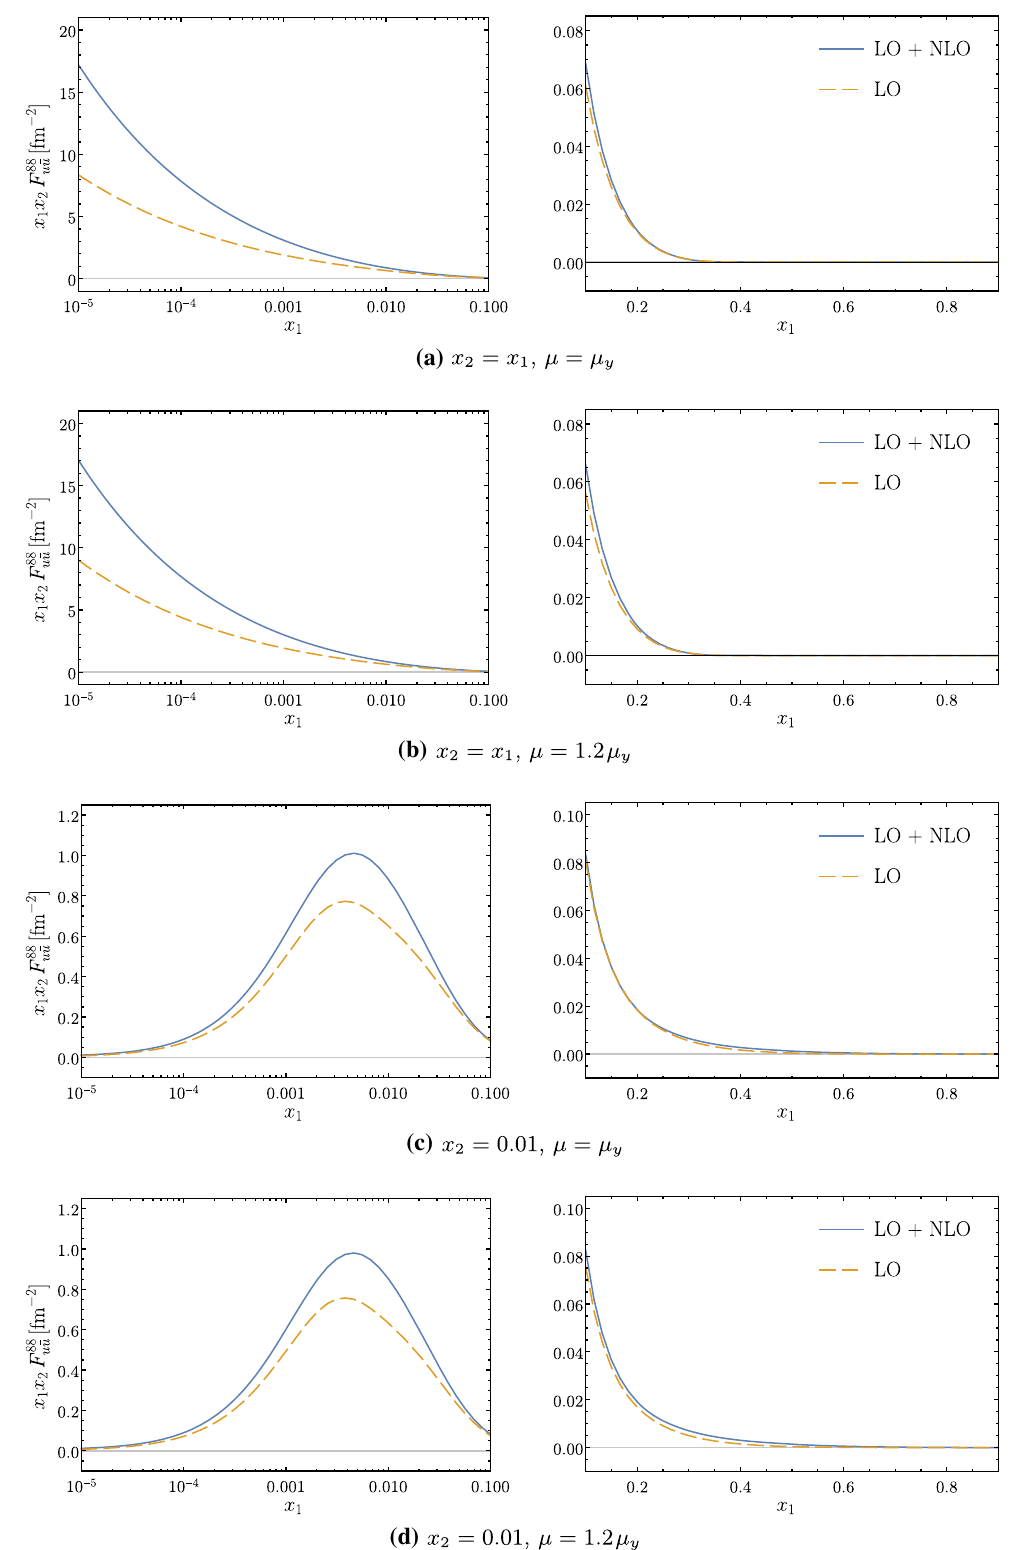
Fig. 12 The distribution F 88 computed for μ y = 10GeV, either with one-loop (LO) or with the sum of one- and two-loop splitting kernels u ¯ u (LO+NLO). All plots are for x 1 x 2 ζ p = μ